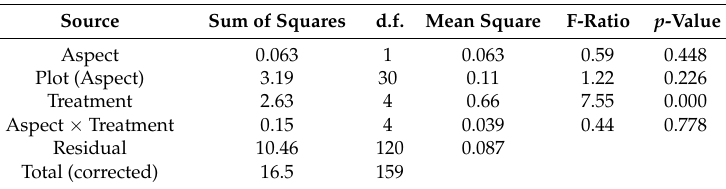
Table 2. Results of the multifactor ANOVA performed to test the statistical significance of each factor included in Equation (1) on seed germination (in log-transformed units) in the study area. The table represents the degrees of freedom (d.f.), F-ratio and p -values for the two fixed effects (and their interaction) and for the plot effect (random). Effects were considered significant when the p -value < 0.05 (95.0% confidence level). Sample data = 160 sub-plots (50 × 50 cm).